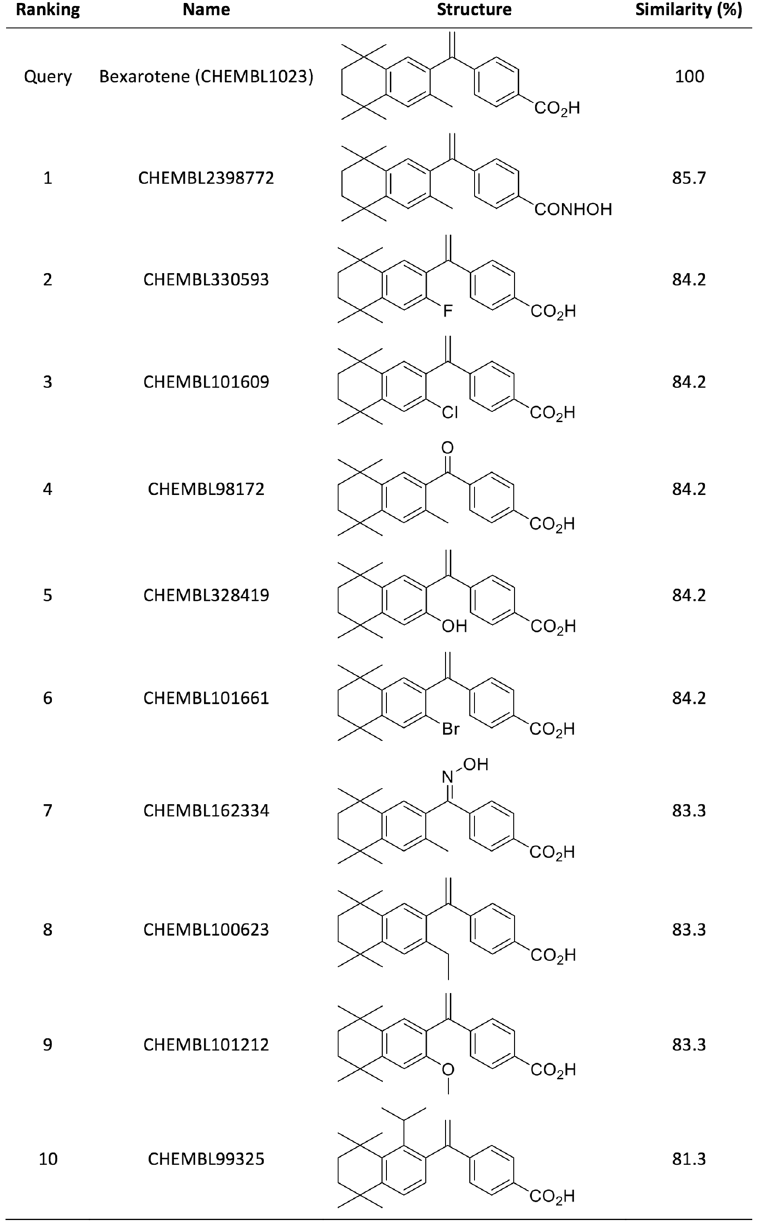
Figure 4. Chemical structures of the 10 most similar database molecules to Bexarotene. This is a L = 1 true positive prediction as these molecules bind the predicted target (Retinoid X receptor